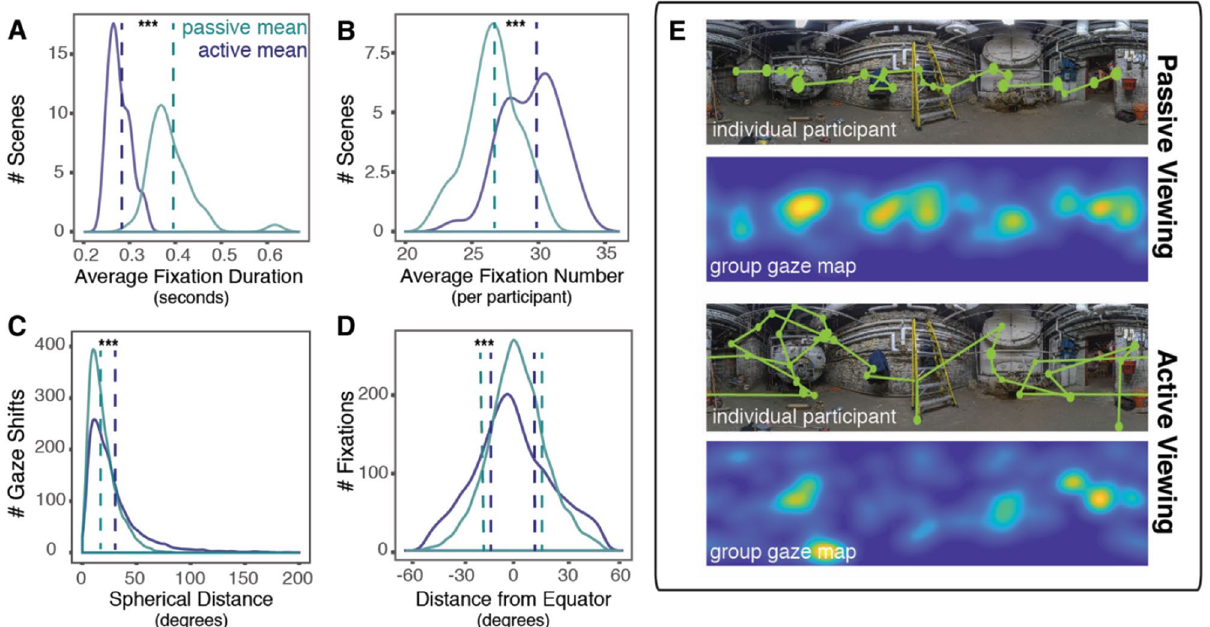
Figure 4. Active viewing impacts eye movements. ( A ) Relative to fixations made in the passive viewing condition, fixations in the active viewing condition were shorter ( B ) and more frequent. ( C ) Gaze shifts in the active viewing condition were also larger, and ( D ) the spatial distribution of gaze in the active viewing condition was less centrally tending. ( E ) Sample duration-weighted fixations and gaze shifts made by a single participant (top) and group fixation map for participants (bottom) per condition. ***Denotes p < 0.001. (Image adapted from Old&New Boiler Panorama by Nathan Tweti)